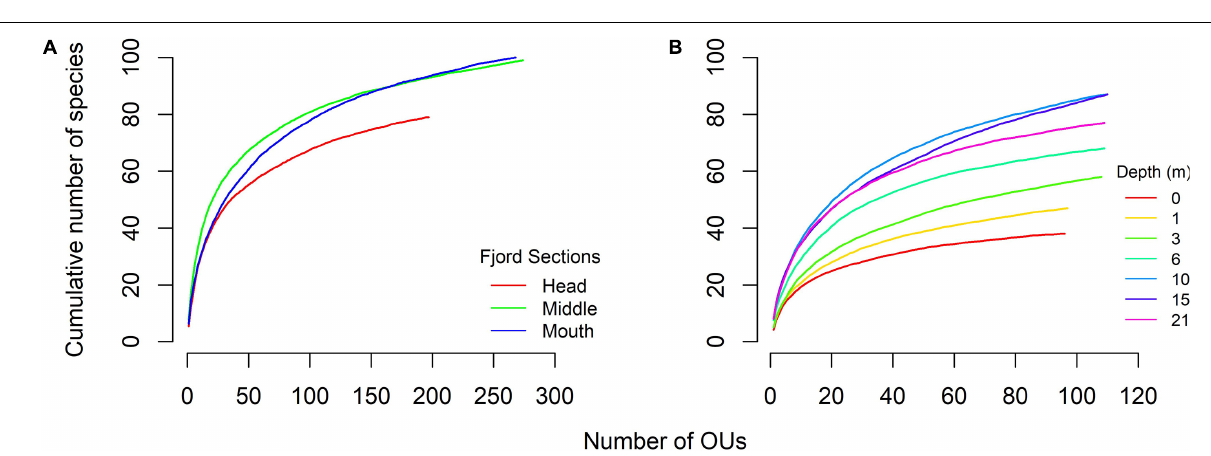
Frontiers in Marine Science |